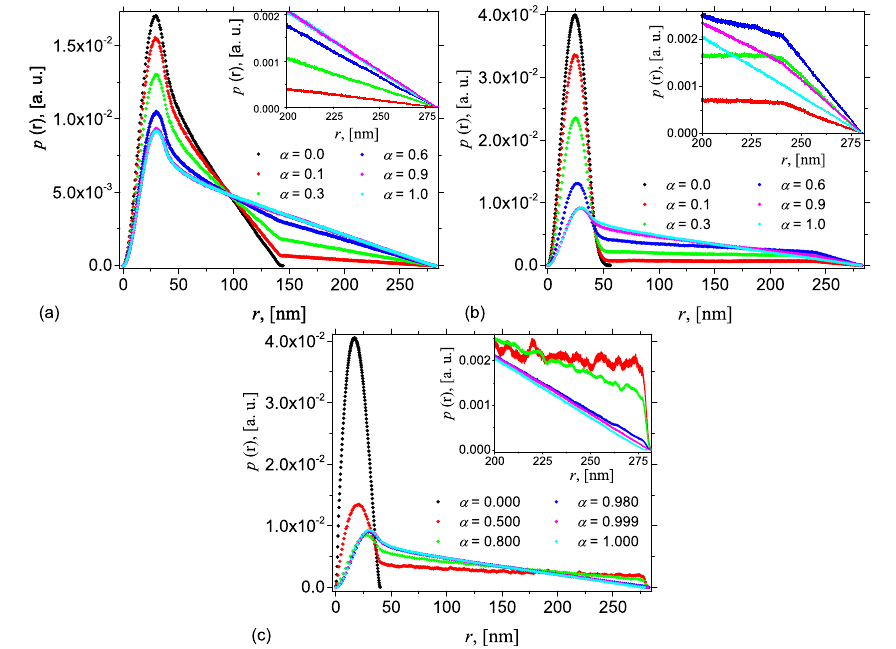
Figure 4. (Color online) Pddf p ( r ) from radially symmetric cylinders with diameter 2 a = 40 nm and height 2 L 0 = 280 nm calculated using the Monte-Carlo simulations, when Region 2 is found at various heights h above a middle-plane parallel to the bases: ( a ) h = 0 nm; ( b ) h = 100 nm; and ( c ) h = 137